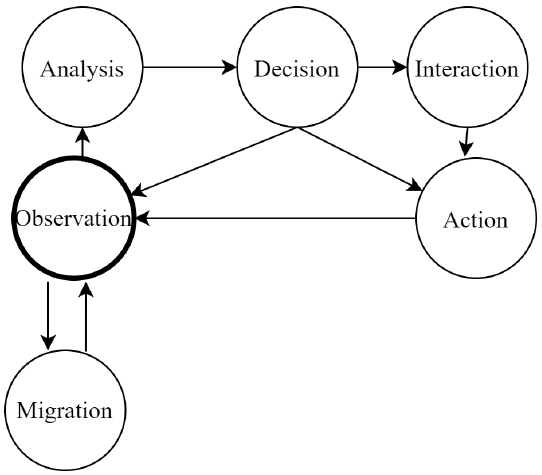
Figure 6. Agent’s possible